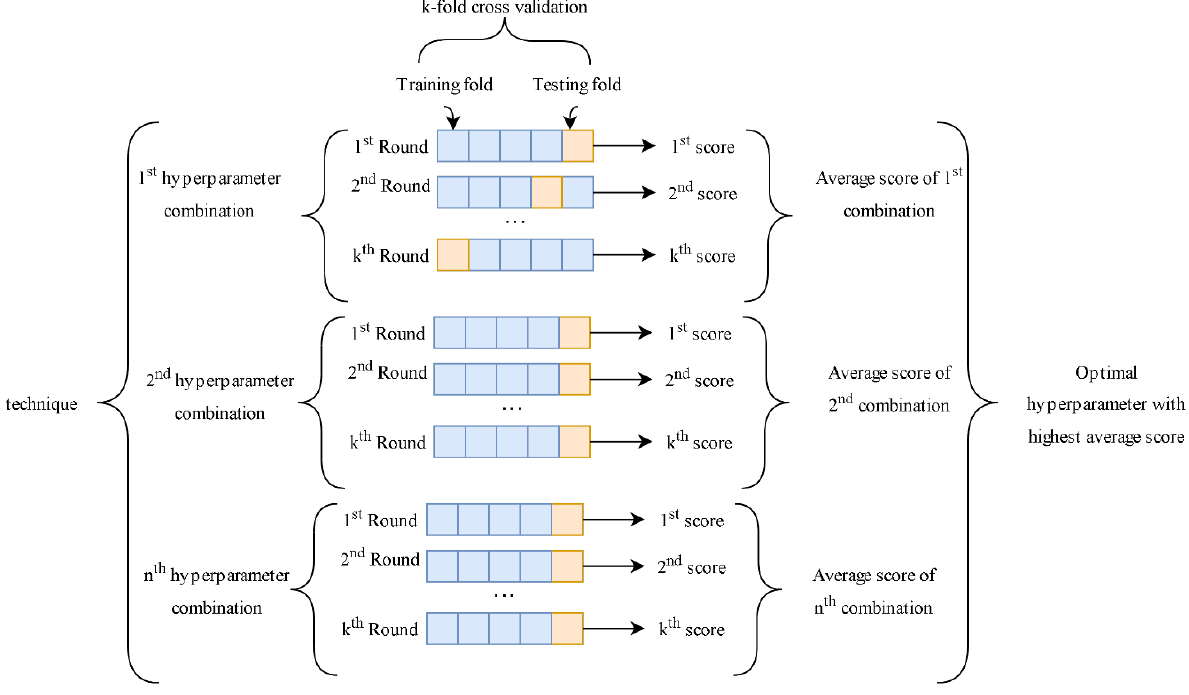
Figure 2. Tuning of hyperparameters using fivefold cross-validation (GridSearchCV).